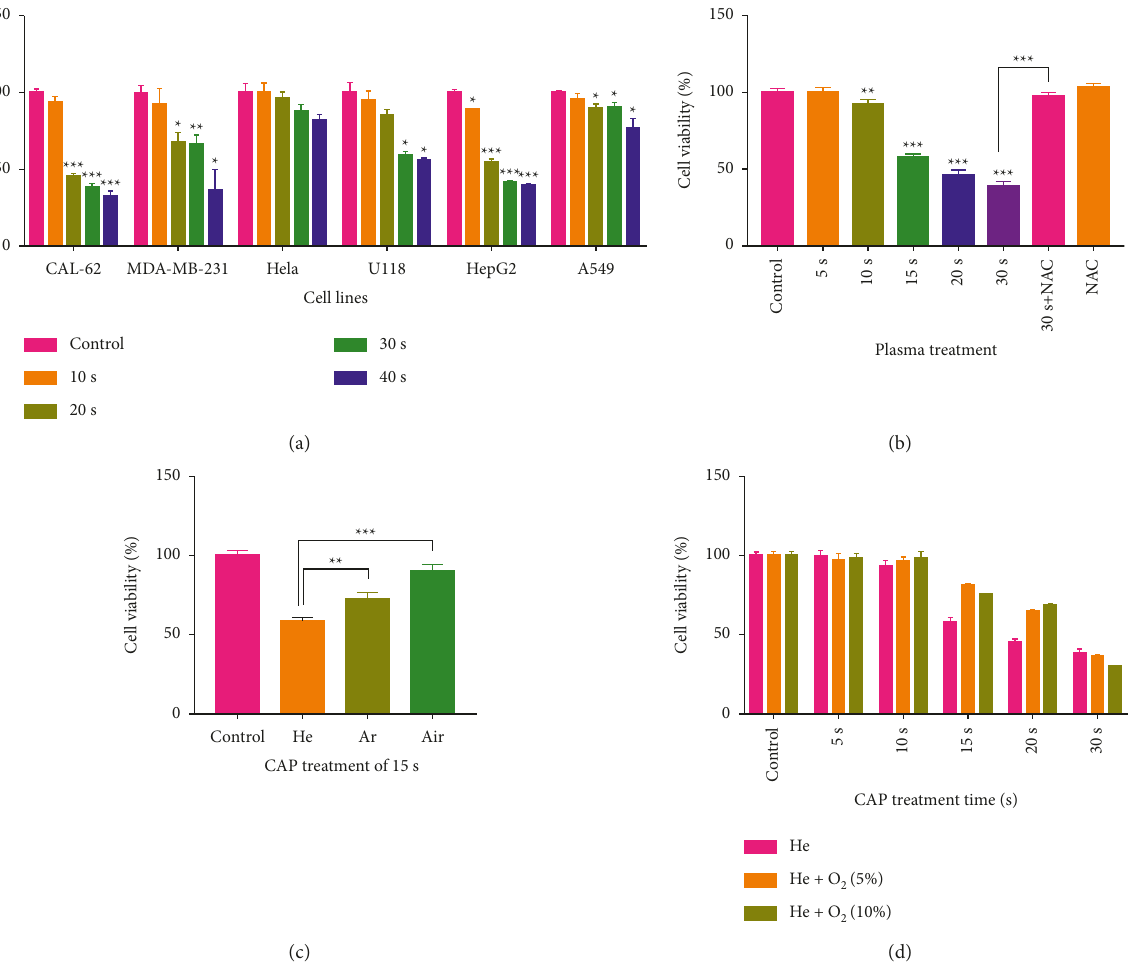
Figure 2: Cell viability assay on cancer cells. (a) CAL-62, MDA-MB-231, HeLa, U118, HepG2, and A549 cells treated with CAP for 10 s, 20s, 30s, and 40 s, or without CAP treatment. (b) The effect of NAC on the viability of CAL-62 cells. (c) CAL-62 cells treated with the gas of helium, argon, and air for 15s. (d) CAL-62 cells treated with CAP for 0s, 5s, 10s, 15s, 20s, and 30 s, and CAP treated in the different oxygen ratios of working gases. At 24 hours after plasma treatment, cell viability was measured by the MTTassay. Data represent the mean ± SD of three independent experiments. ∗ p < 0 . 05, ∗∗ p < 0 . 01, and ∗∗∗ p < 0 . 001 with ANOVA compared with the